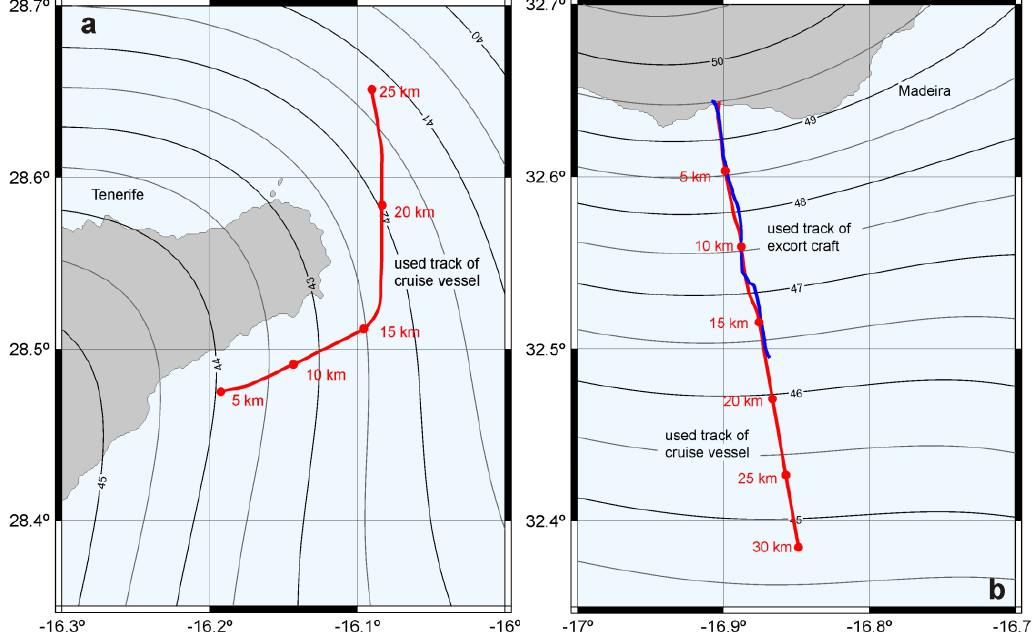
Figure 15. Tracks of cruise vessel and escort craft during departure (a) and arrival (b) used to derive a squat function for the cruise vessel. Sailed distance along the track (a) and distance from shore line (b) in km.